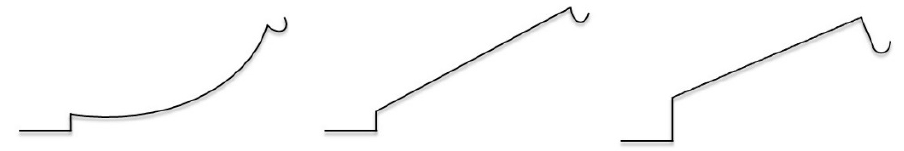
Figure 1. Different cantilever designs (activated). From the left: deep curve, tip back, and utility arch.